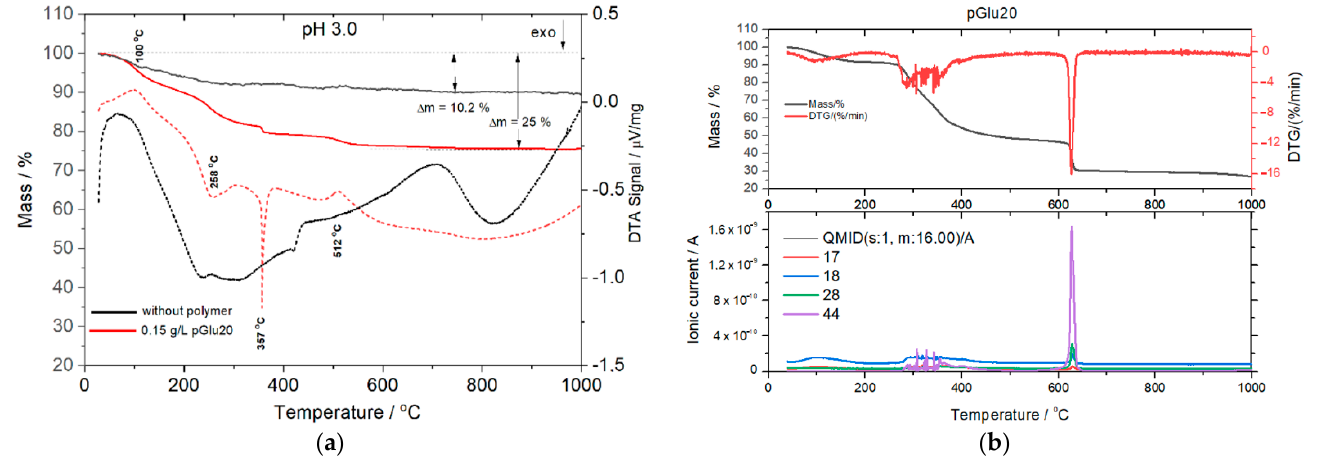
Figure 4. ( a ) TG/DTA curves of the materials drawn at pH 3.0 without the additive and in the presence of 0.15 g/L pGlu20 measured at 5 K/min up to 1000 °C in an air atmosphere. ( b ) TG/dTG-MS curves of pGlu20 powder at 5 K/min up to 1000 °C in an Ar-20%O 2 atmosphere.